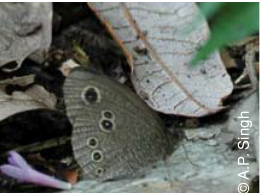
Image 93. Large Goldenfork, Zophoessa goalpara (under)